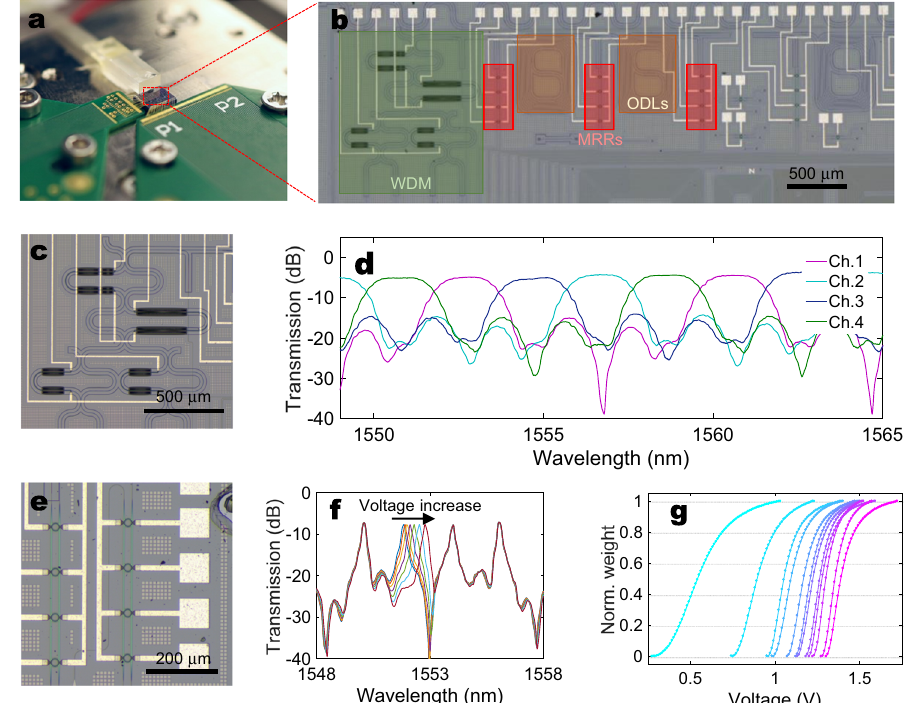
Fig. 2 | Chip fabrication and characterization. a Photograph of the packaged PTFP chip. Optical signals enter and leave the chipvia an edge-coupled fi ber array. b LayoutofthePTFPchip.FourwavelengthsarecombinedintheWDM.Twooptical delaylines(ODLs)aredeployed toprovidethreedelaysteps.Beforeandaftereach ODL, weighting banks with four MRRs in each are implemented. c Photograph of the WDM. d Transmission spectraofthe WDM. e Regionalphotograph of the MRR